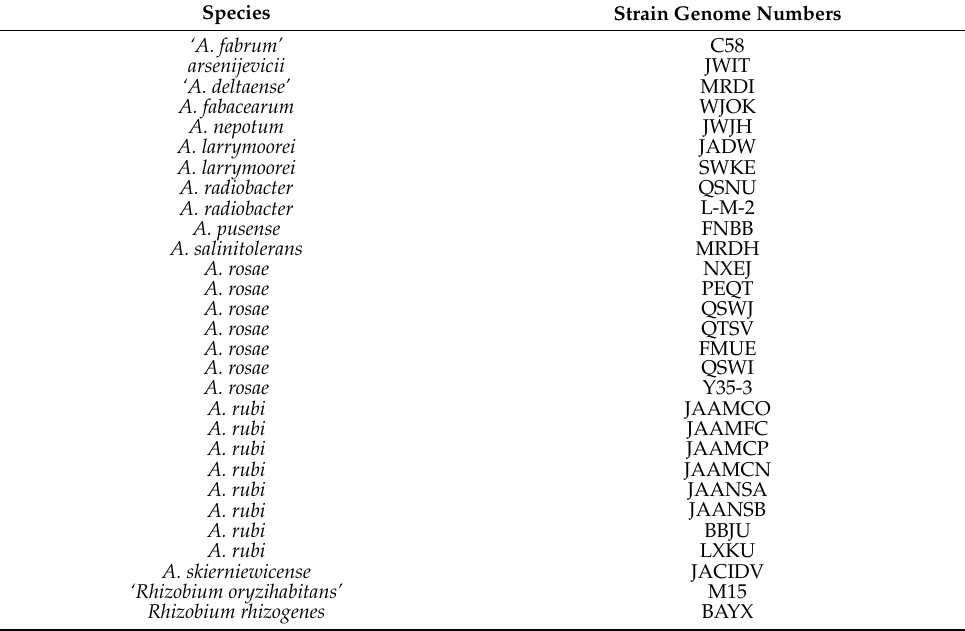
Table 1. Species and GenBank accession numbers of the strains in phylogeny